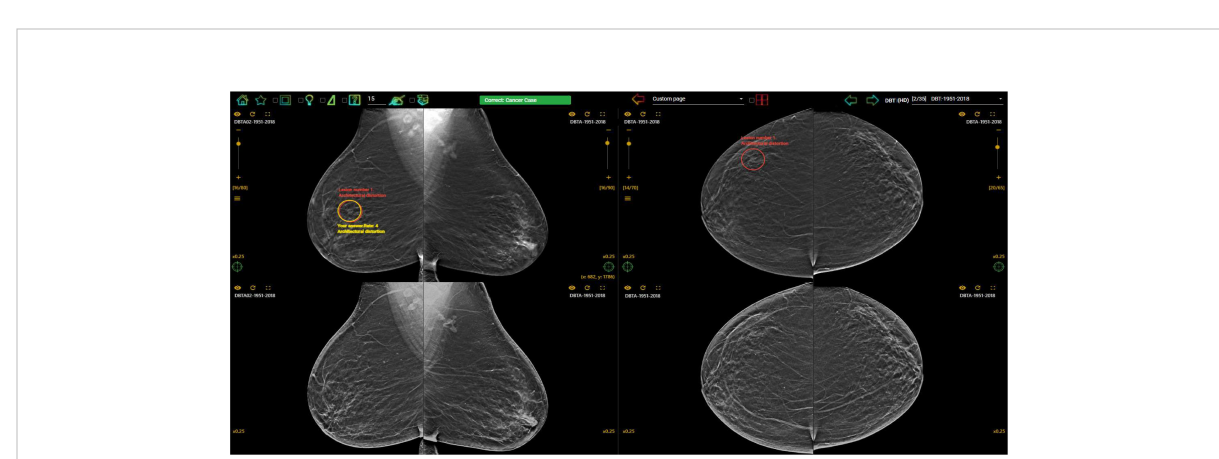
FIGURE 4 Feedback onthe BREAST platform for a DBT case interpreted by a radiologist with a correct cancer location detectiononthe DBT slice (red circle (truth)and yellow circle(user ’ s marking) wereoverlapped)onRMLO (Right Mediolateral Oblique) view anda missed cancer location (red circle)onRCC (Right Craniocaudal)view. The fi rst row displayed DBT images and synthesized viewswereshown onthe secondrow (www.breastaustralia.com).